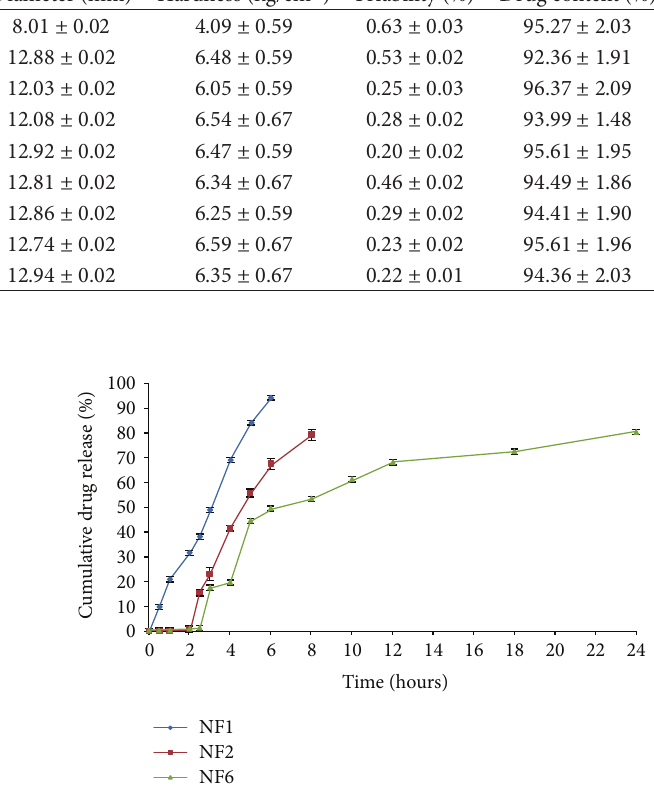
Figure 3: Comparative in vitro release profiles of naproxen sodium coretablets(NF1),press-coatedHPCtablets(NF2),andpress-coated Eudragit RSPO:RLPO tablets (NF6). Data are expressed as mean ± S.D. ( 𝑛 = 3